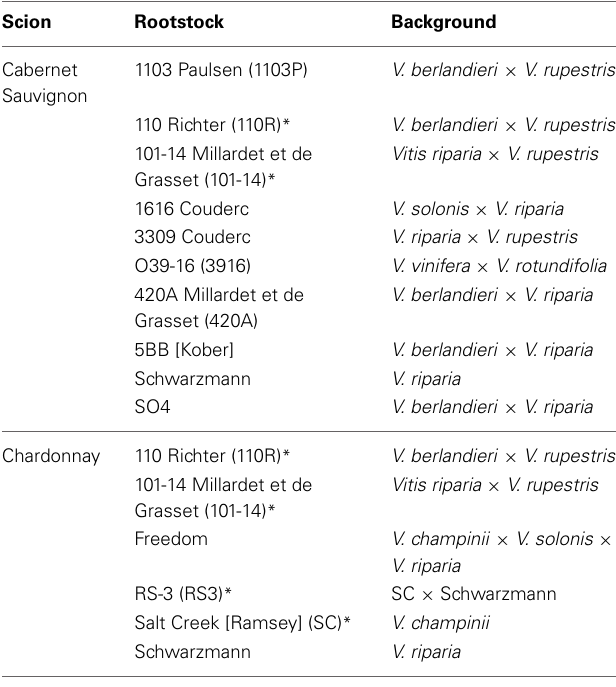
Table 1 | Scion and rootstock combinations used in this study, with information about the wild Vitis spp. in the background of the rootstocks